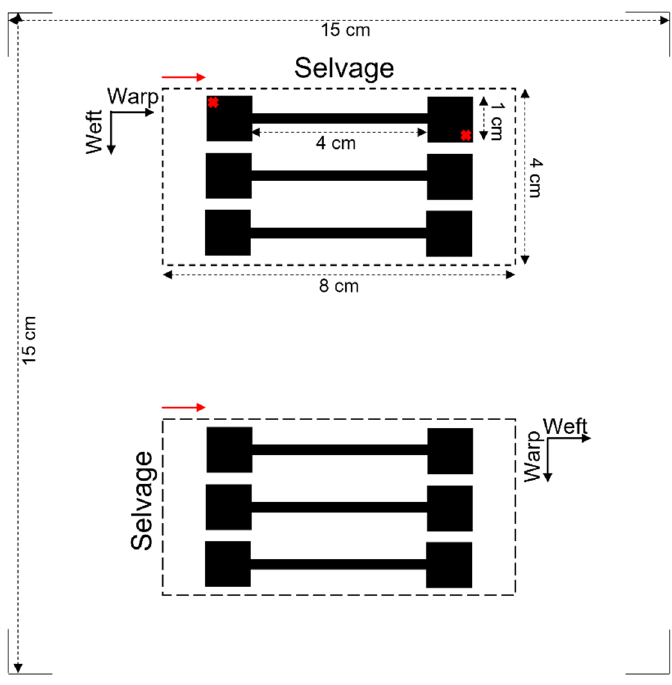
Figure 1. Designed printing image for characterisation of electroless copper coatings. Red arrows show the printing direction. Samples placed on the top and bottom were printed in the warp and weft directions, respectively.